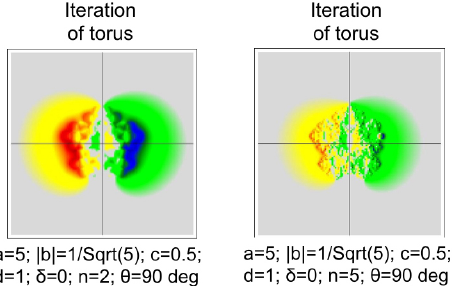
Figure 6. By iterations of the torus model we can obtain the fractal structure of magnetograms.